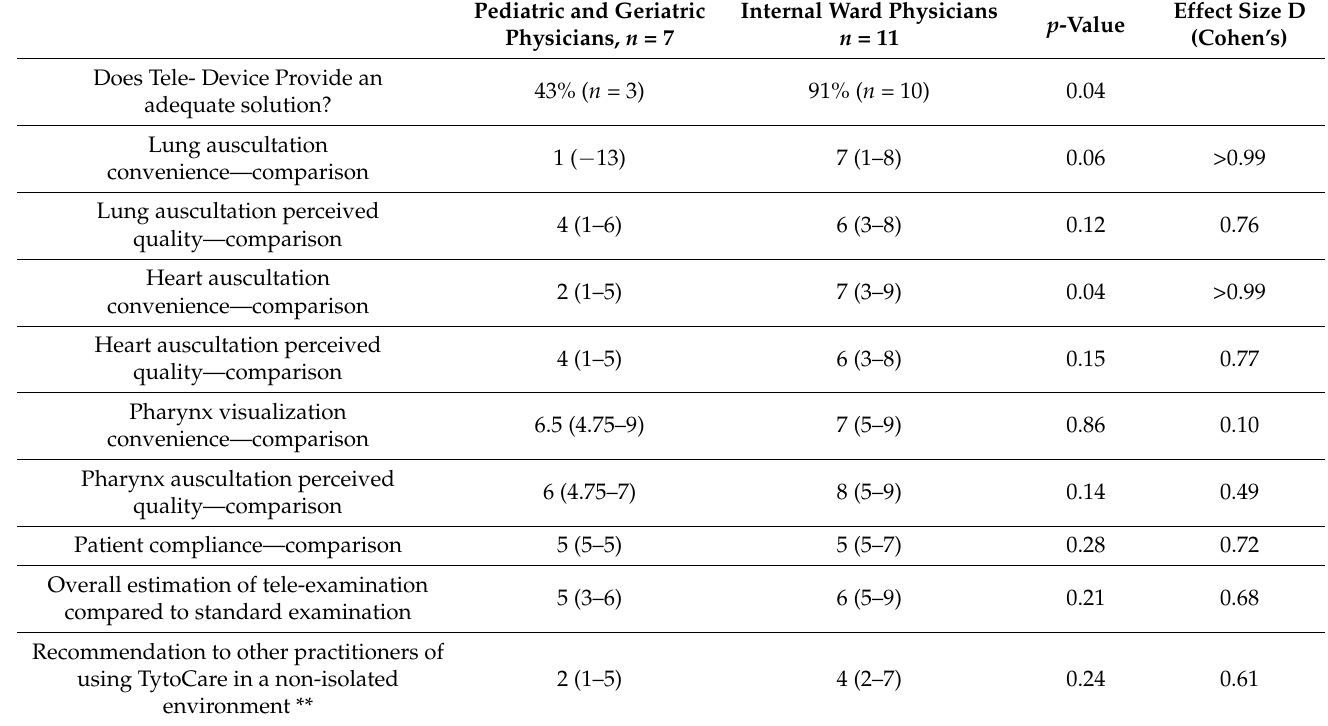
Table 5. Tele-physical examination user (physician) experience evaluation according to physician specialization: score of 5 marking indifference between modalities while 1 indicates a major preference in favor of the standard physical examination and 9 indicated a major preference in favor of the TytoCare ®